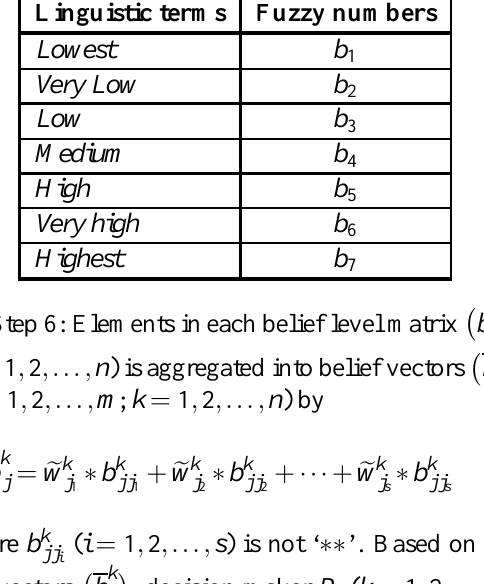
Table 3. Linguistic terms for preference belief levels for alternatives Linguistic terms Fuzzy